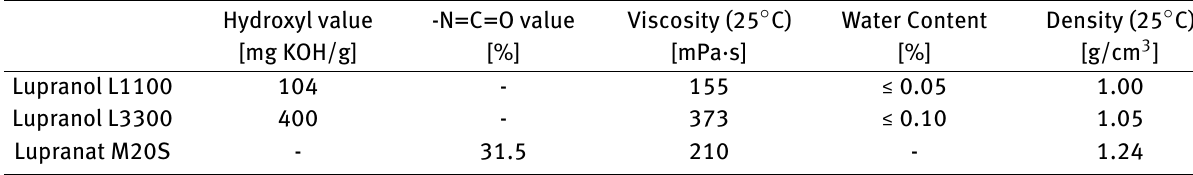
Table 1: Physical properties of Lupranol L1100, L3300, and Lupranat M20S according to the materials data sheet